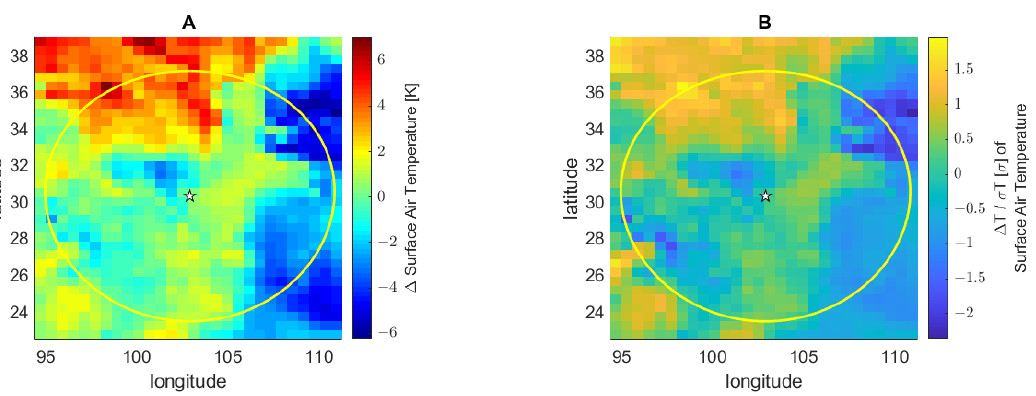
Figure 23. Maps of differences in surface air temperature, Δ T ( A ) and Δ T/ σ T ( B ) on 11 December 2012. The yellow circle represents the Dobrovosky radius of the Mw 6.7 Lushan 2013 earthquake. The white star indicates the epicenter of Mw 6.7 Lushan 2013 earthquake.